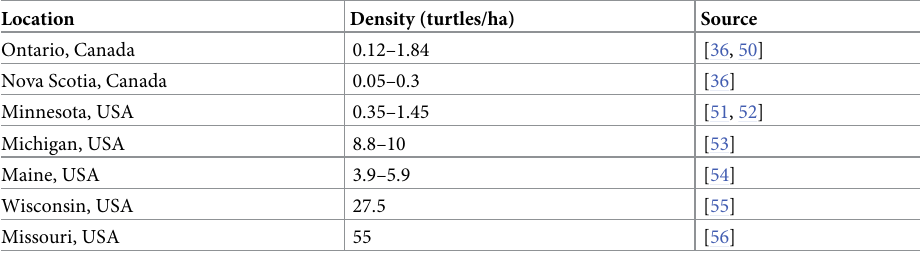
Table 3. Densities of adult Blanding’s Turtle in populations from Canada and the